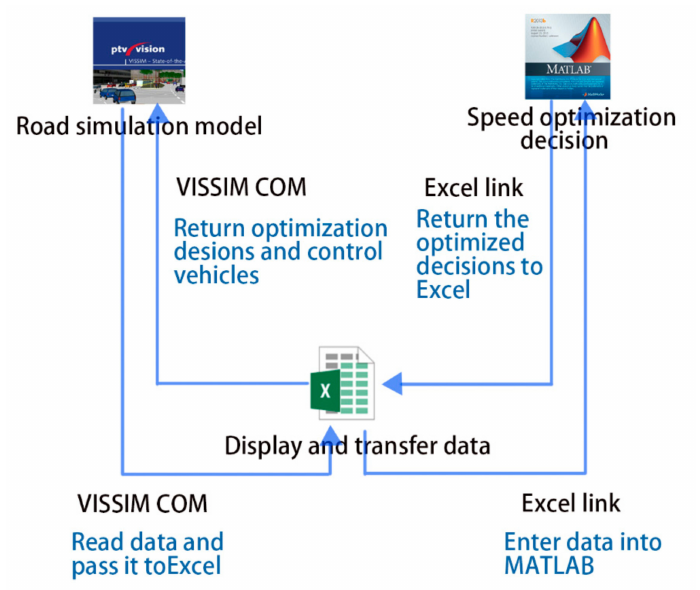
Figure 3. Principle of calling and controlling of the simulation model.